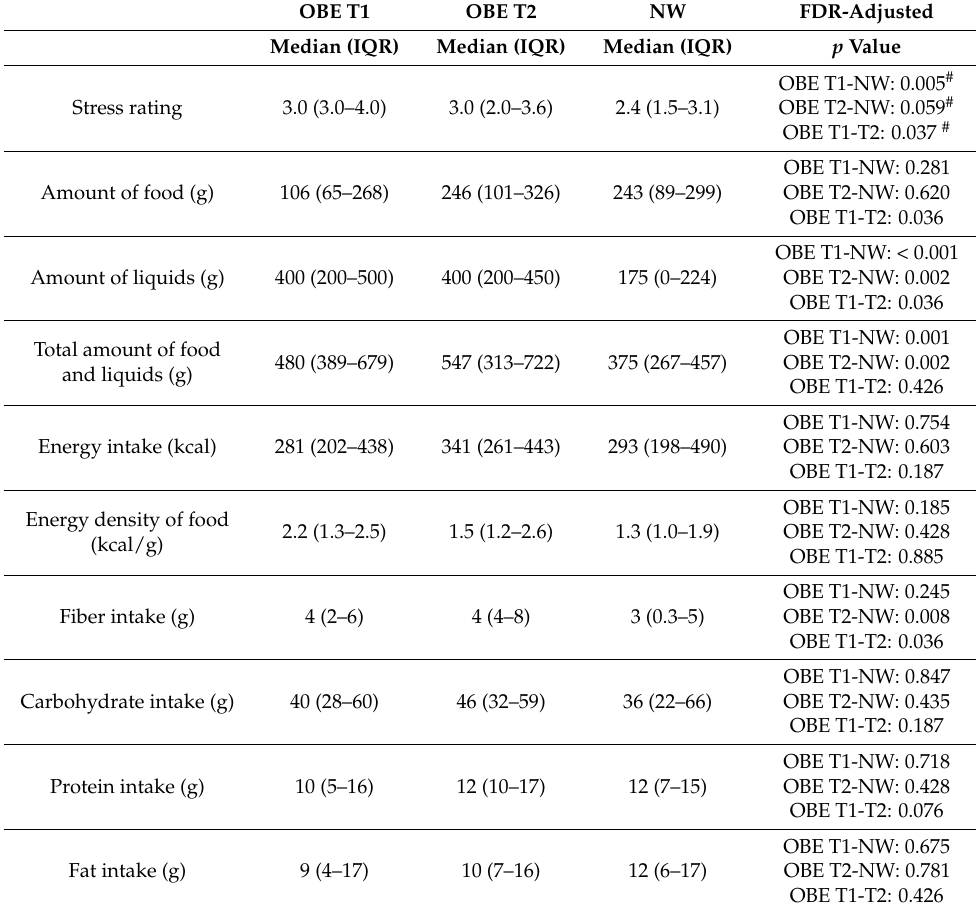
Table 5. Parameters of food intake two hours before the water load test in obese children (OBE) before (T1) and after (T2) weight loss in comparison to normal-weight control children (NW). OBE